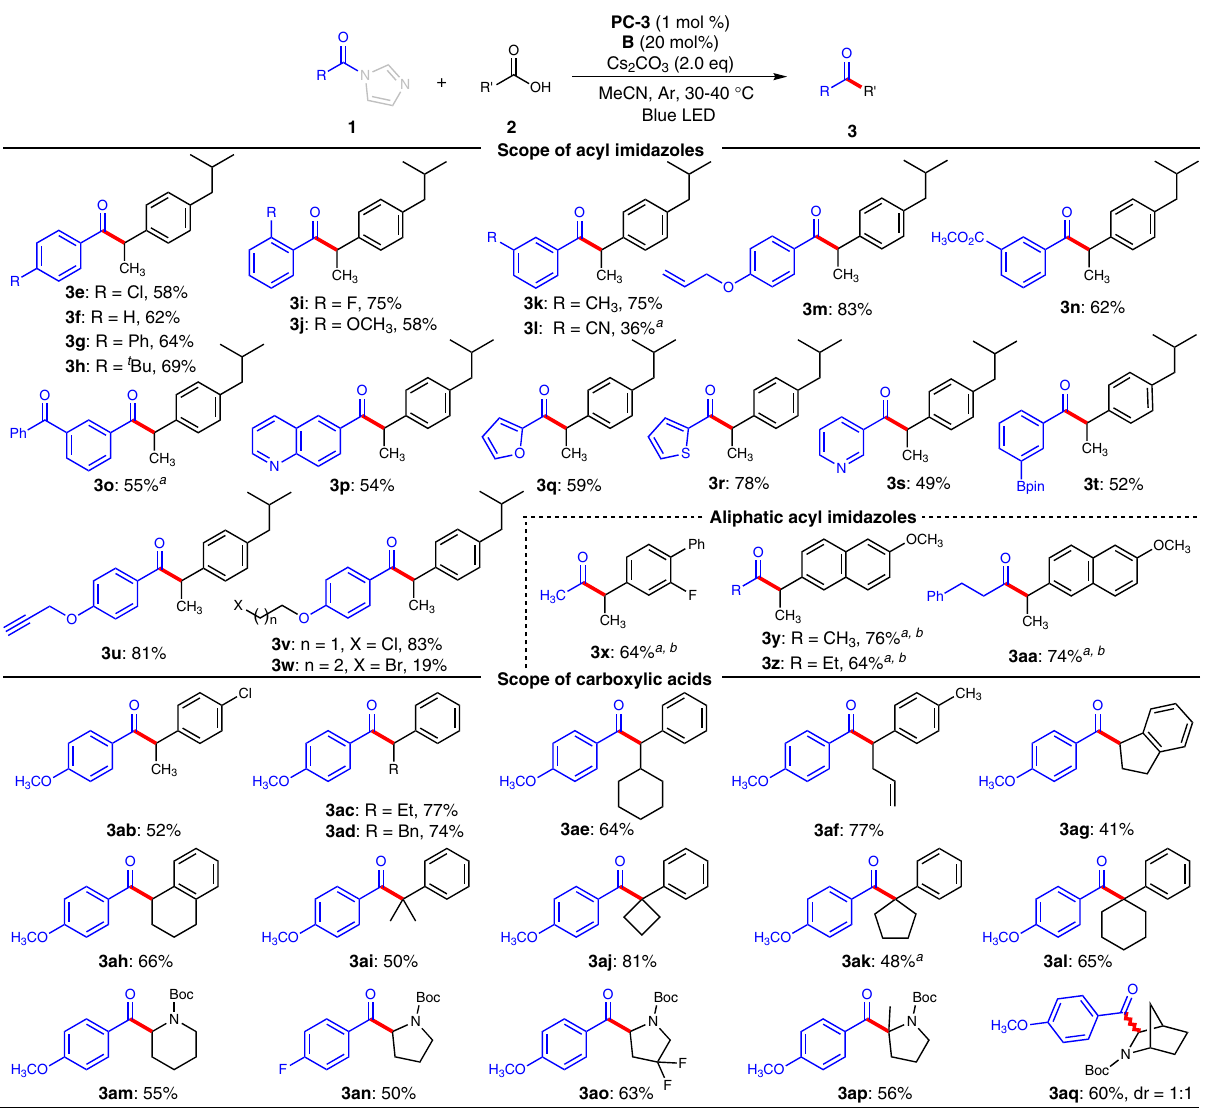
Fig. 3 Scope of the reaction. Reaction conditions: 1 (1.5 equiv), 2 (0.1 – 0.2 mmol), B (20 mol %), PC-3 (1 mol %) and Cs 2 CO 3 (2.0 equiv) in MeCN (2.0 mL), blue LED (Kessil PR160 series, λ max = 427 nm), Ar atmosphere, 30 – 40 °C, 24 h. a Blue LEDs (Kessil PR160 series, λ max = 440 nm) were used. b 1.2 equiv Cs 2 CO 3 was